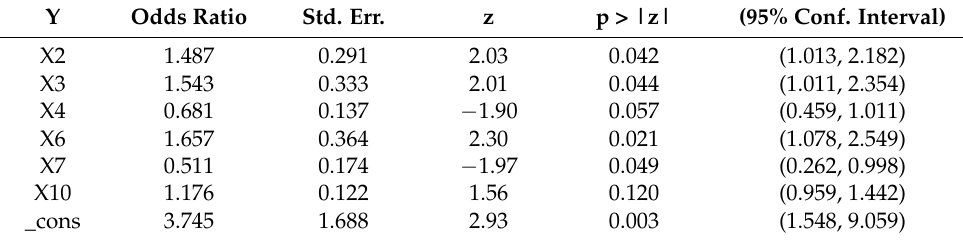
Table A8. The seventh step of stepwise logistic